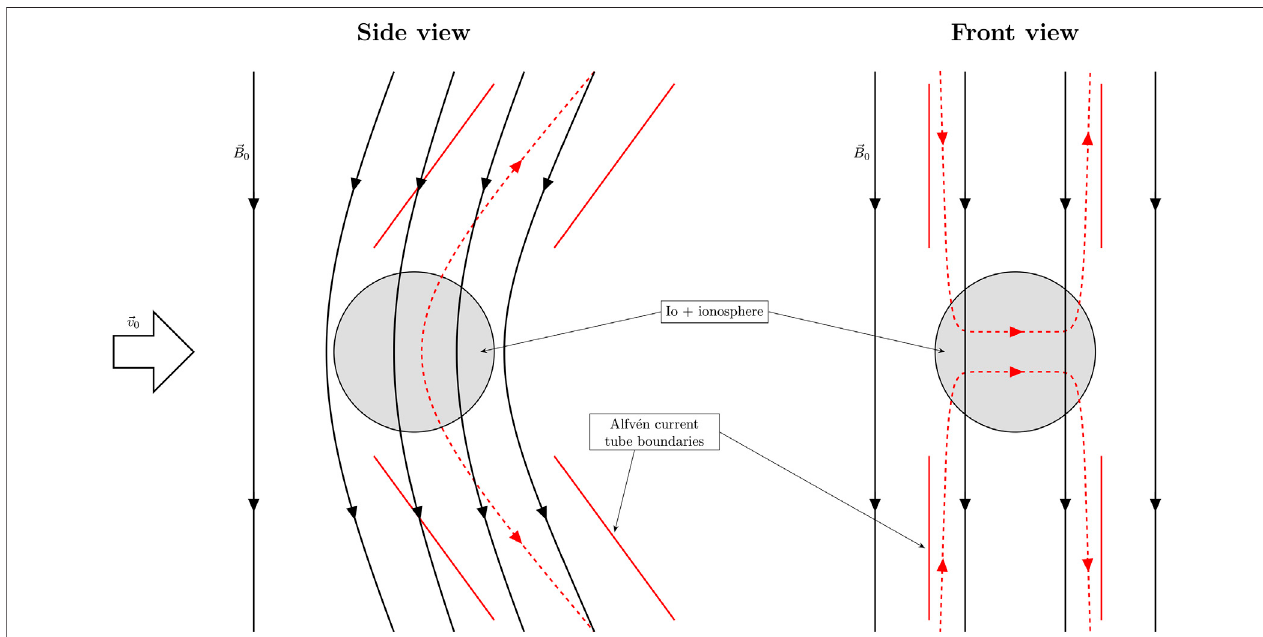
FIGURE3| Standing Alfvéncurrent tubemagneto-spheric disturbances,termed Alfvénwings,thatspread andpropagateawayalong fi eldlines inboth directions. ThedevelopmentoftheAlfvénwingsareobservableintheregionswithdecreasingplasmabulkvelocity v 1 andperturbedmagnetic fi eld B 1 northandsouthofIointhe xz plane.ItisknownthattheAlfvéncurrenttubesarebentbackbyaconstantanglewithrespecttotheunperturbedbackgroundmagnetic fi eld.Further,theperturbationof the magnetic fi eld is positively correlated with the perturbation of the velocity fi eld in the northern Alfvén wing and negatively correlated in the southern wing [133].